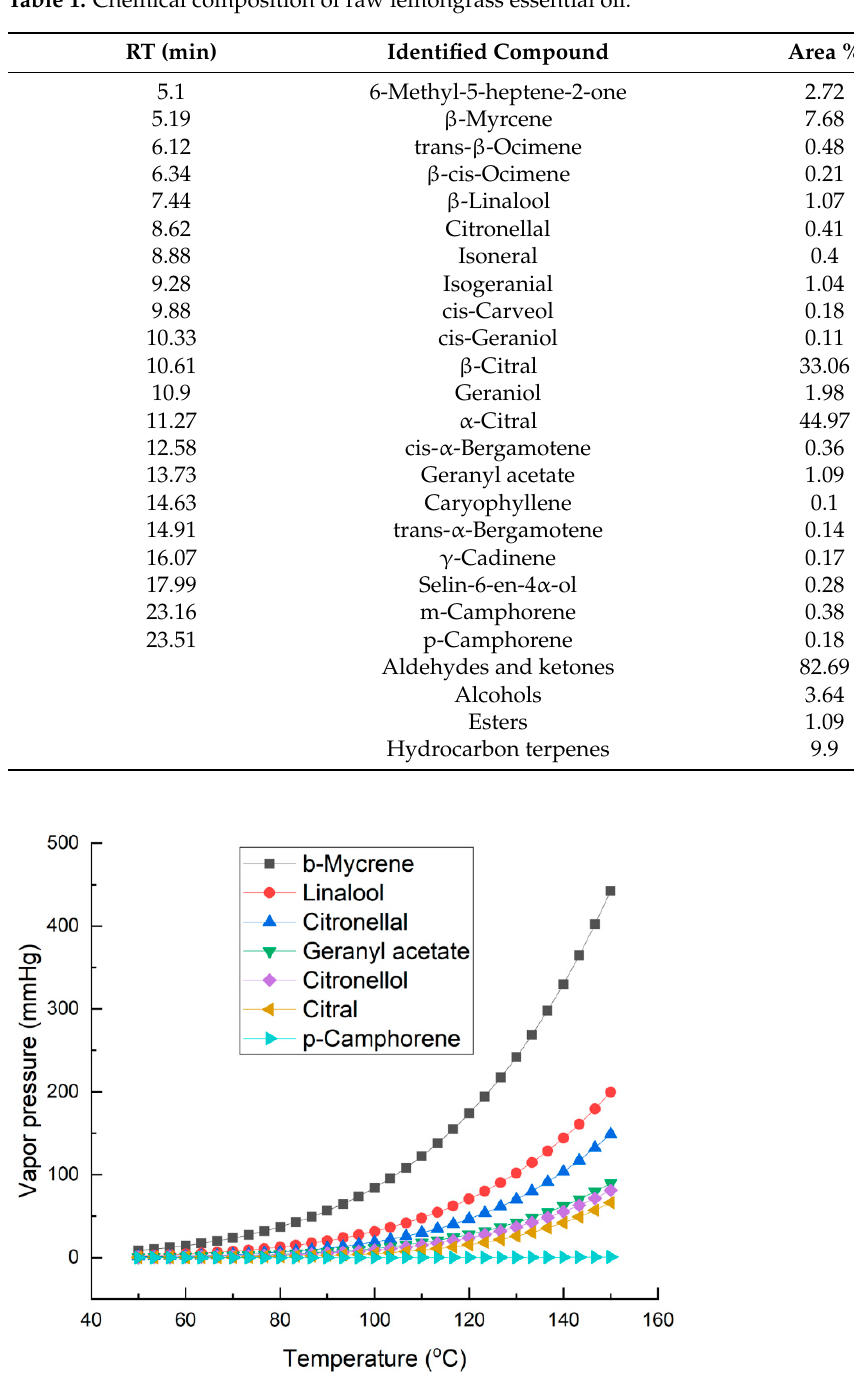
Table 1. Chemical composition of raw lemongrass essential oil.